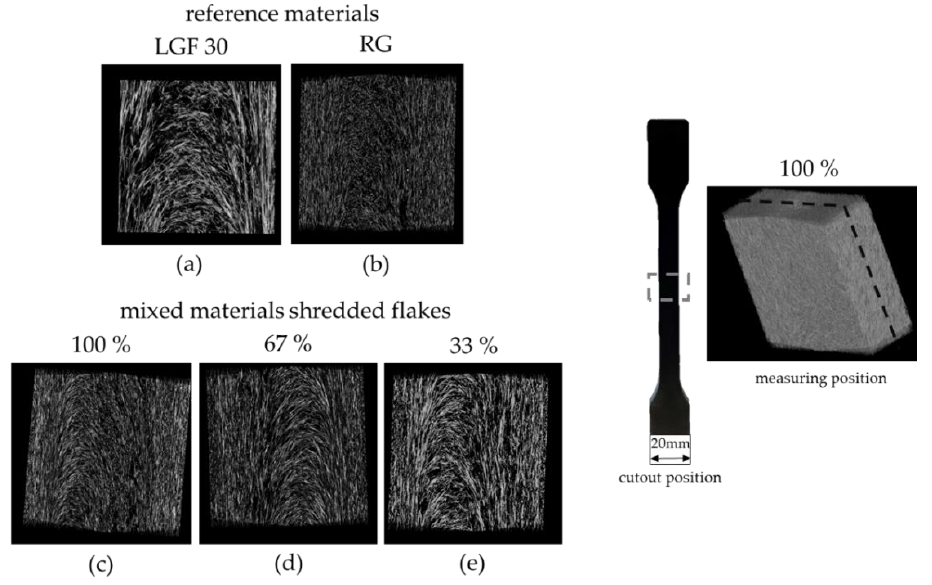
Figure 9. CT images comparing the fiber lengths and fiber orientation of the reference materials (( a ) LGF30 and ( b ) RG) and the mixed materials with the shredded flakes (( c ) 100 wt.-%, ( d ) 67 wt.-%, and ( e ) 33 wt.-% of recycled material); with a resolution size of 4.5 µm voxel.